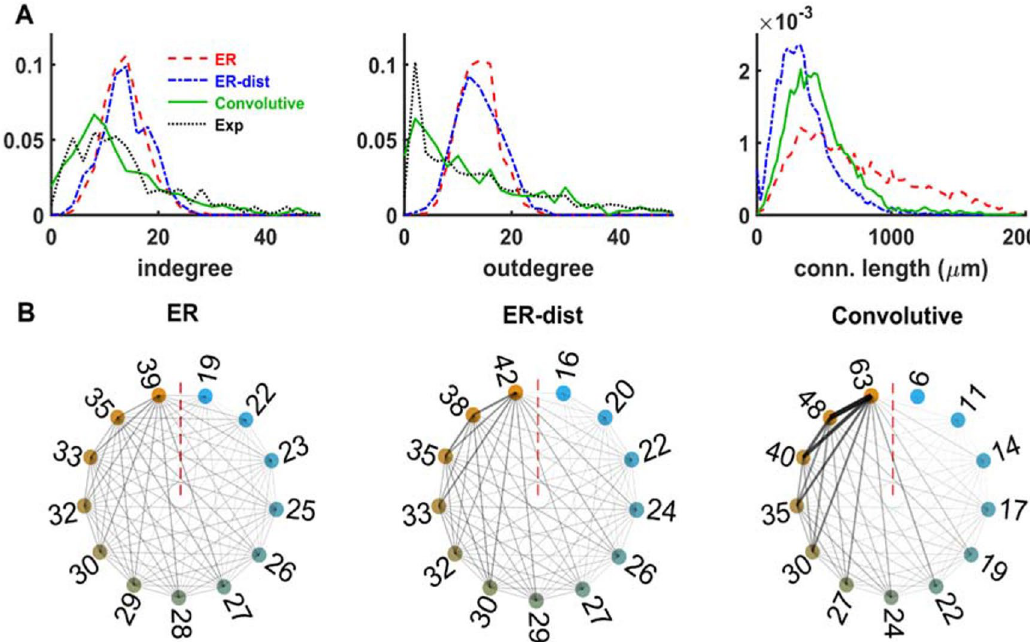
Figure 2. Neurons distributed in a thick rectangular volume. ( A ) In-degree distribution (left), out-degree distribution (middle) and connection length distribution (right) for networks of Epileptors connected as an ER model (red), ER with distance (blue) and using a convolutive model (green) fitted to experimental C. elegans data (black, connection length was not available). ( B ) Circular graph representation of connectivity for the ER model (left), the ER-dist model (middle) and Convolutive model (right). See the main text for an explanation of how they were constructed. The lines thickness and transparency are proportional to the number of connections between any two given